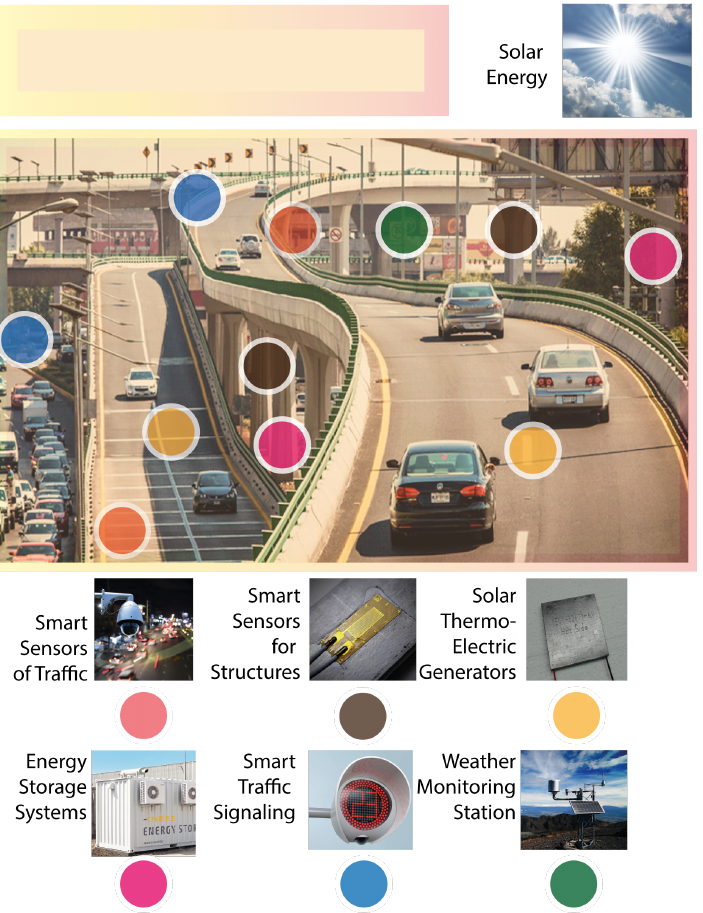
Figure 1. Smart system example for the management of traffic using solar thermoelectric generation in urban